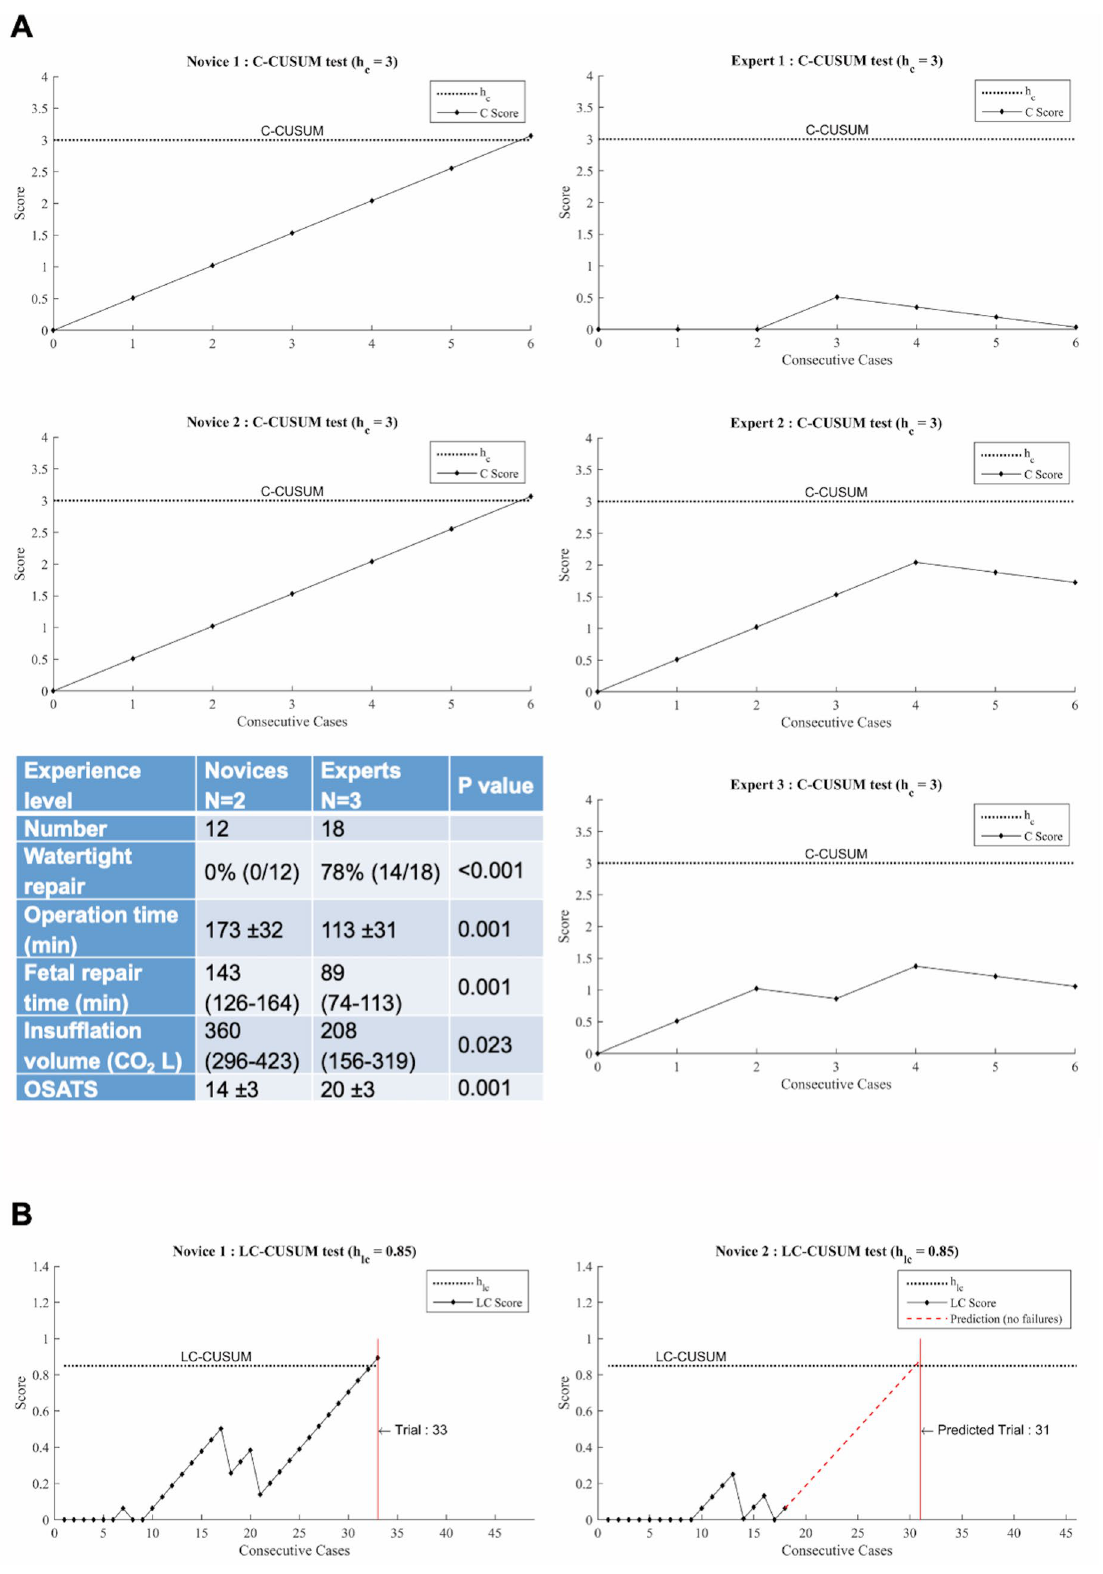
Figure 2. Construct and criterion validity of our training model. ( A ) Construct validity: competency assessment of novices and experts using competency cumulative sum (C-CUSUM) test (graphs), and comparison of clinical outcomes of the first six cases of novices and experts using the group splitting method (table). ( B ) Criterion validity: learning curve assessments of novices and experts using learning curve CUSUM (LC-CUSUM) test